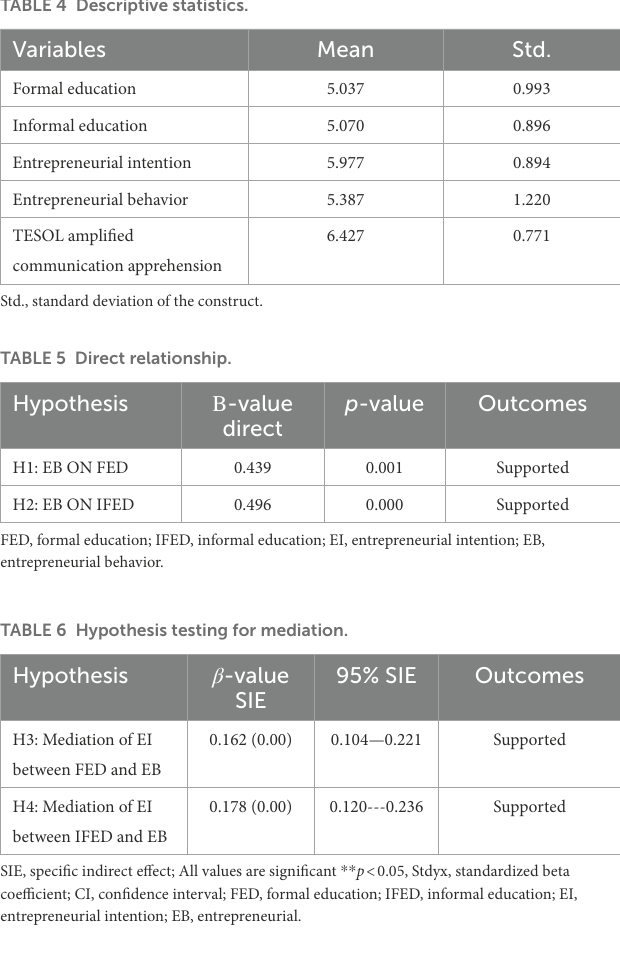
TABLE 4 Descriptive statistics.